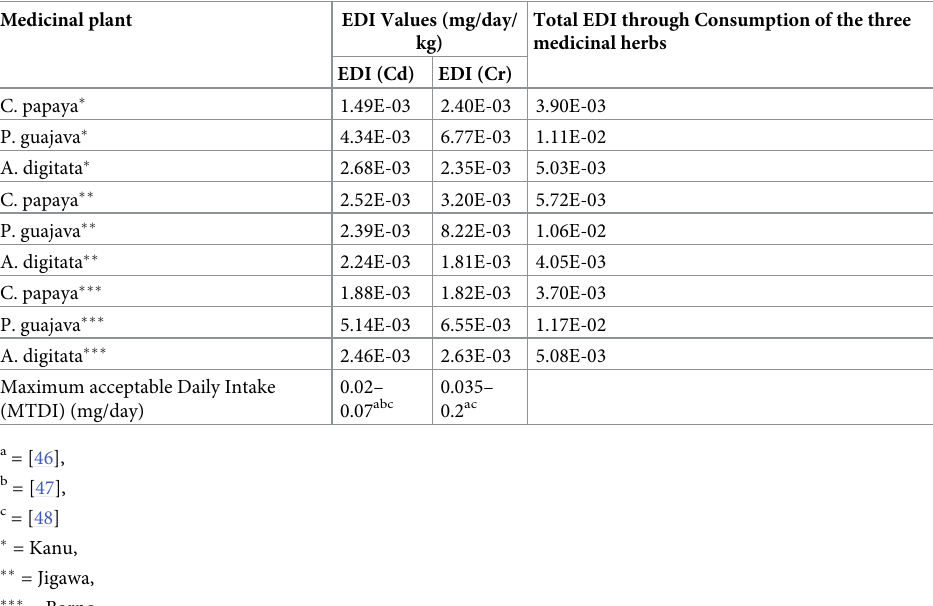
Table 9. The EDI of heavy metals in mg/day/kg body weight from the consumption of the medicinal herbs from Kano, Jigawa and Borno. Medicinal